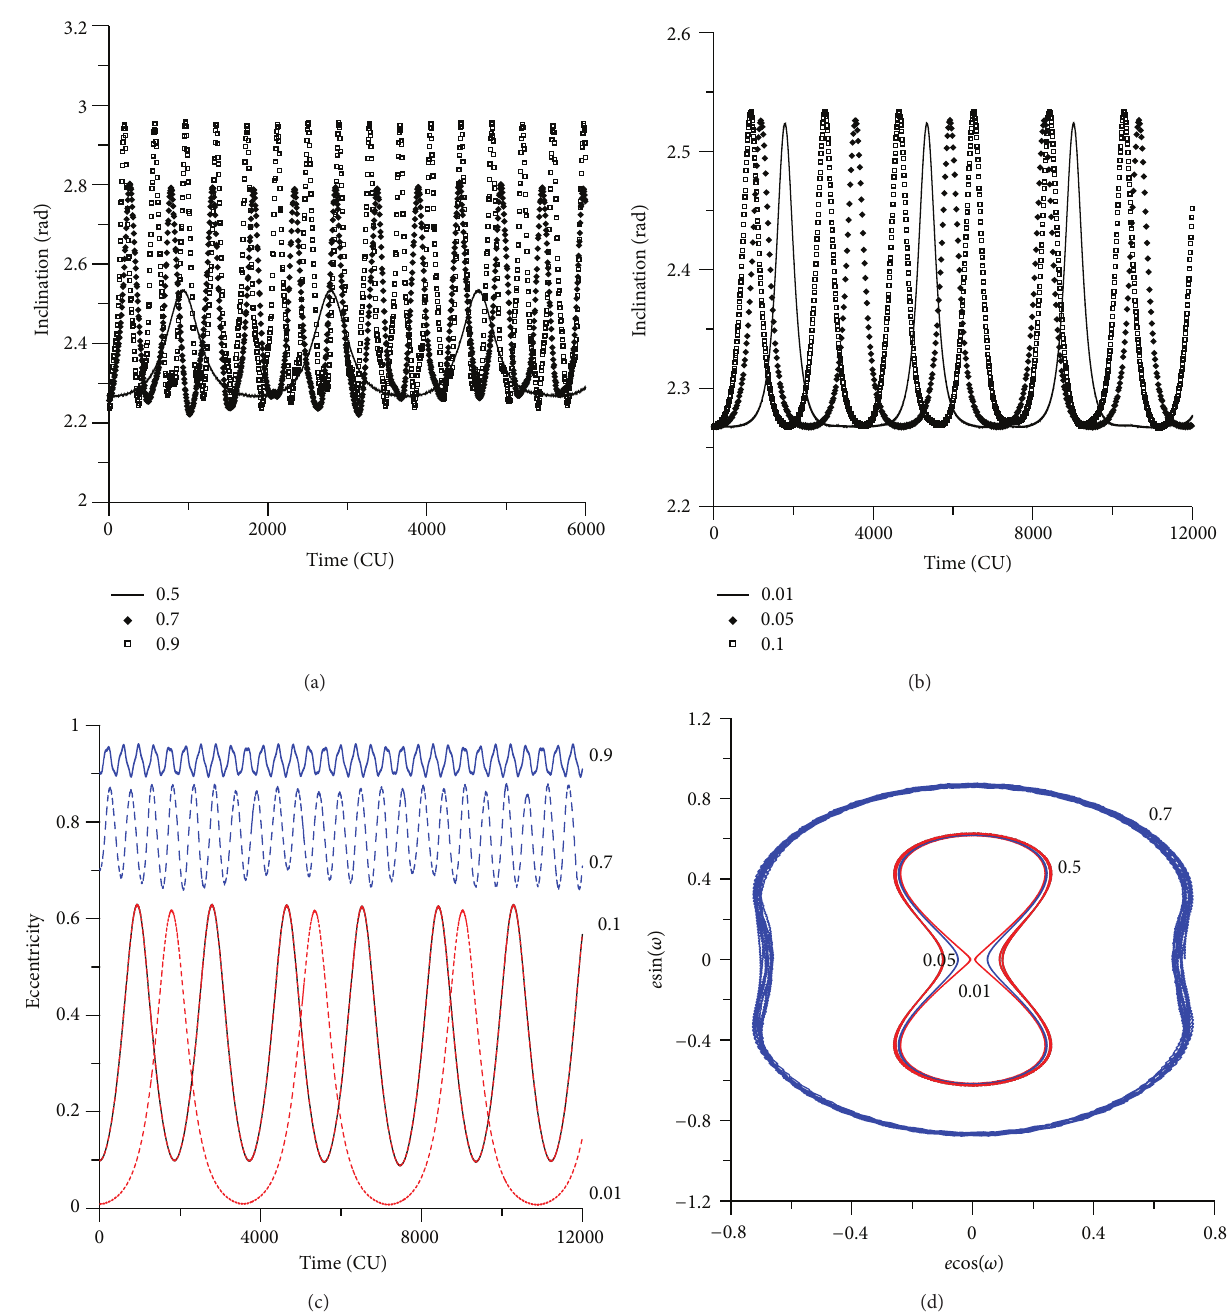
Figure 14: Behavior of the orbital elements for an initial inclination of 130 degrees. The values for the eccentricity are 0.01, 0.05, 0.10, 0.50, 0.70, and 0.90. The initial conditions are a = 0.341 canonical units, M 0 (0) = 0, 𝜔 (0) = 0, and Ω (0) =